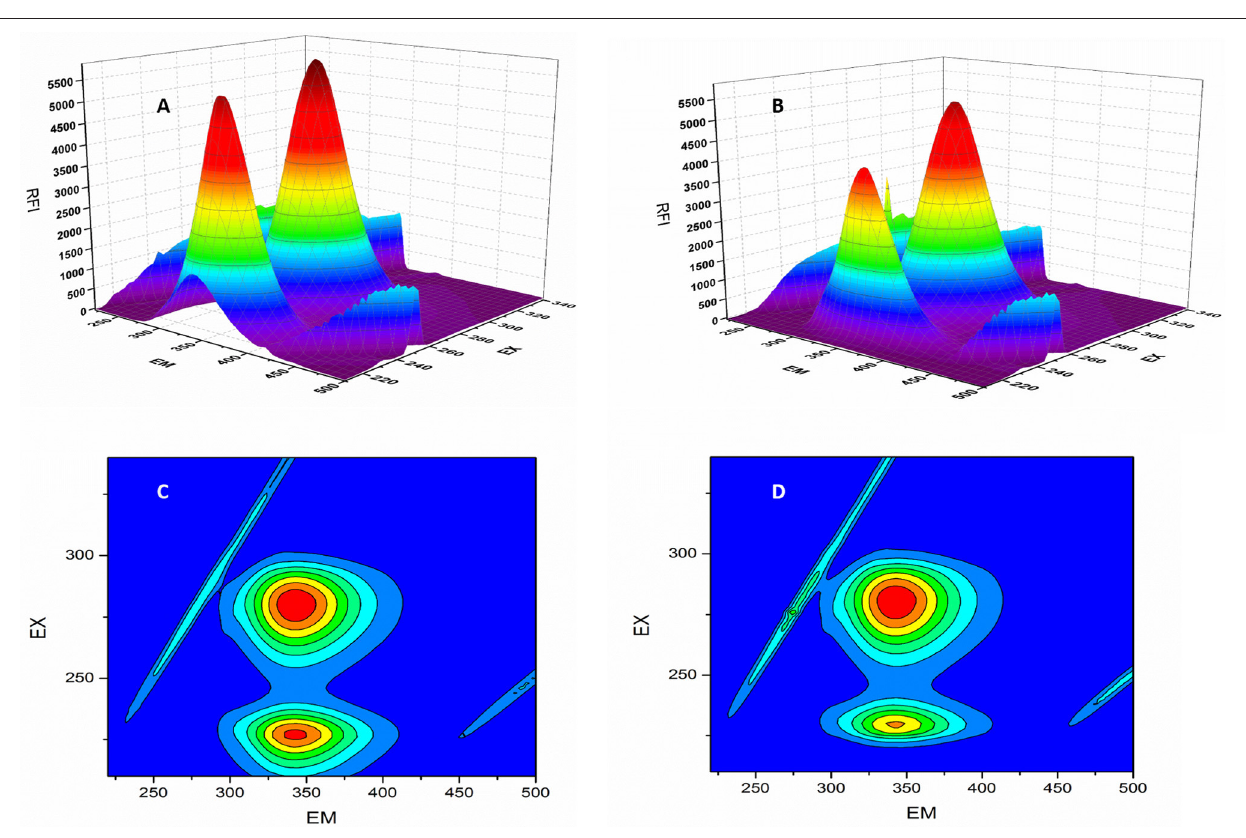
BSA molecule. Peak 2 was found at the excitation and emission wavelength of 280 and 342 nm, respectively. Tryptophan and tyrosine residues are responsible for the formation of Peak